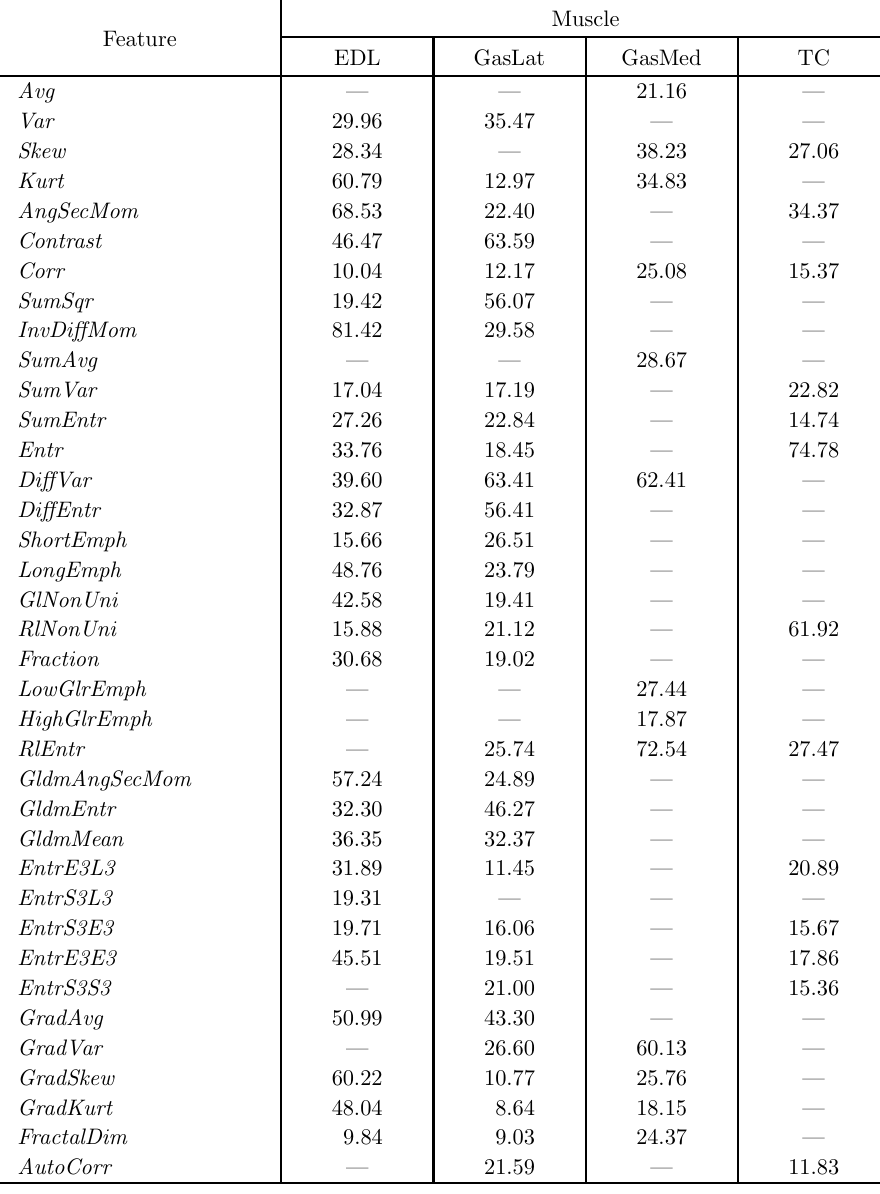
Table 5. The first (i) differentiation problem: the first phase vs. the second phase. Features marked by an em dash (“—”) demonstrated statistically significant differences between the considered phases of growth in healthy dogs ( α = 0.05). The remaining features were used in the identification of dystrophy phases in GRMD dogs. The corresponding numbers are incidences of selections [%] in the modified MC